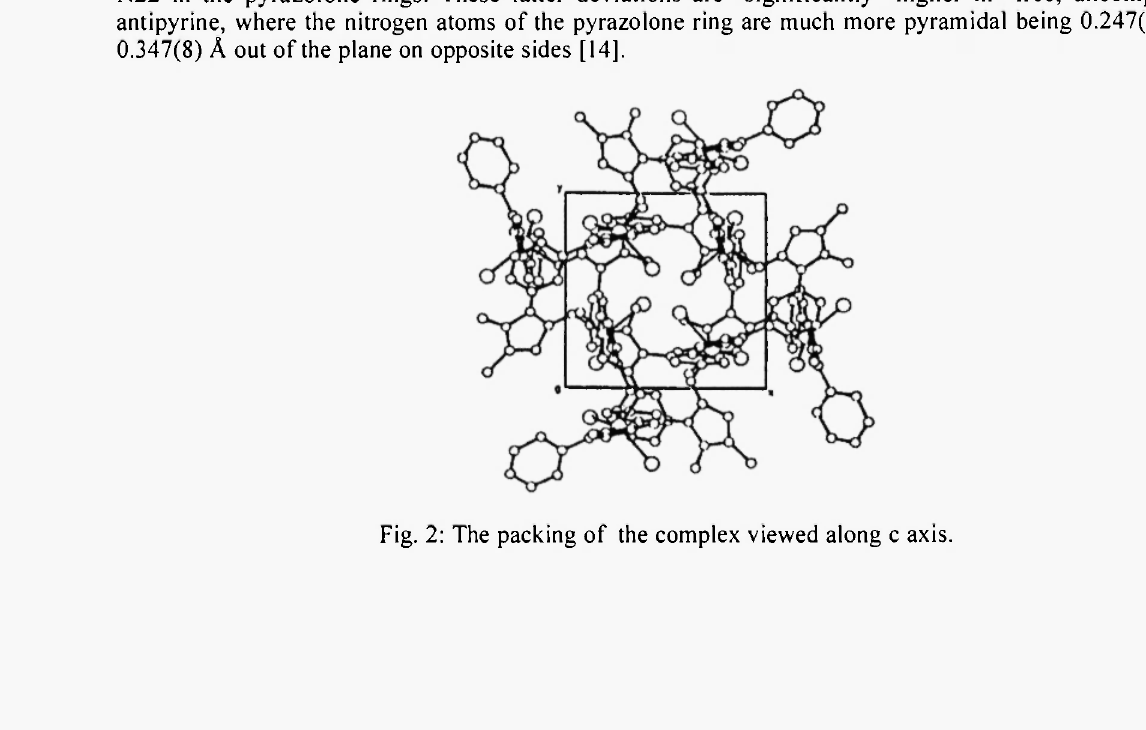
Fig. 2: The packing of the complex viewed along c